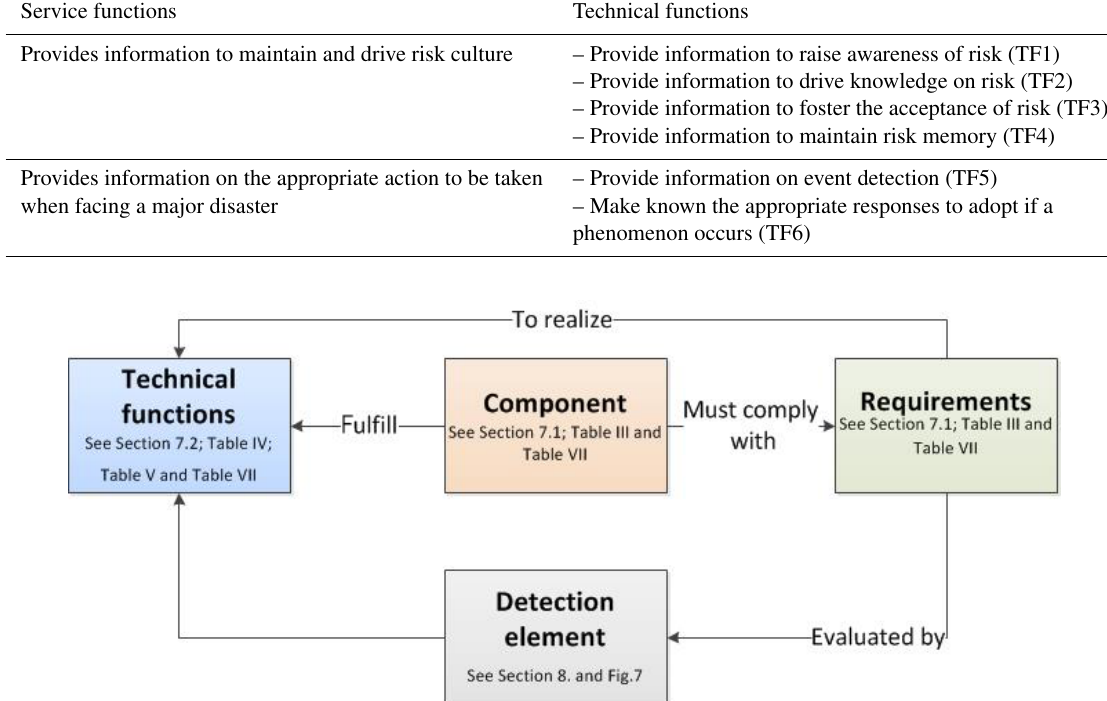
Figure 4. Role of the entities of the